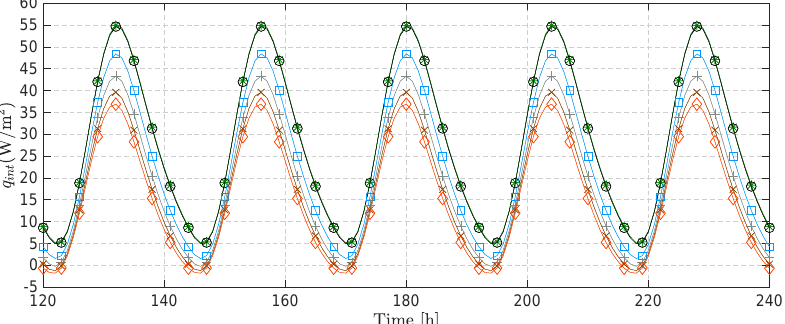
Figure 3. Heat flux distribution over time at the interior surface of the brick wall (bare facade)— sensitivity to wind speed, v : ( ∗ ) 0.0 m/s; ( ◦ ) 0.5 m/s; ( (cid:3) ) 1.5 m/s; (+) 2.5 m/s; ( × ) 3.5 m/s; ( (cid:5) ) 4.5